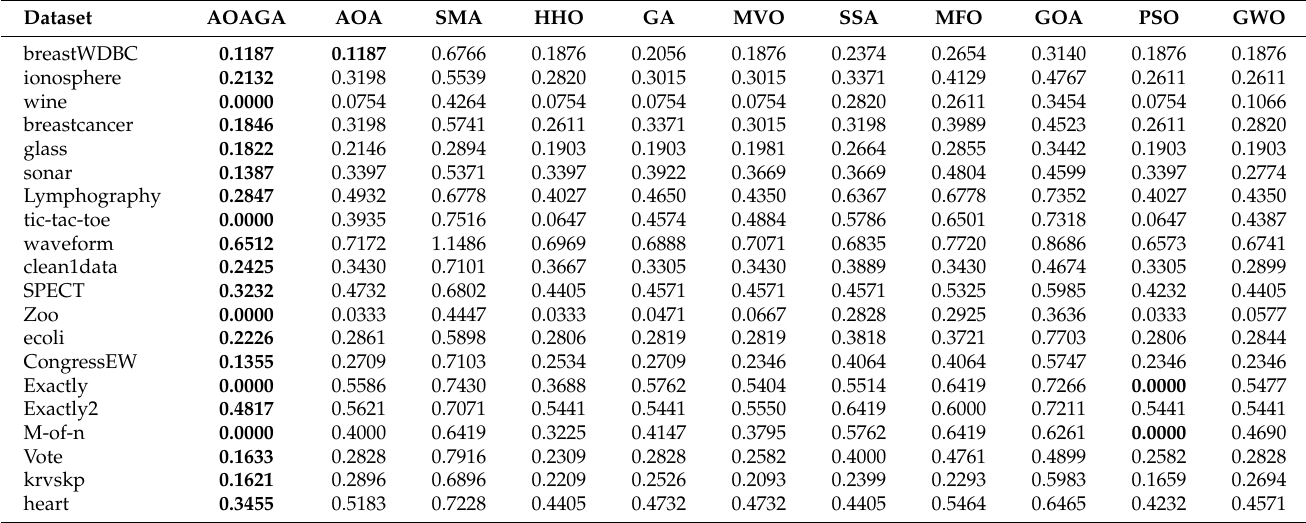
Table 4. Results of the MAX measure for all